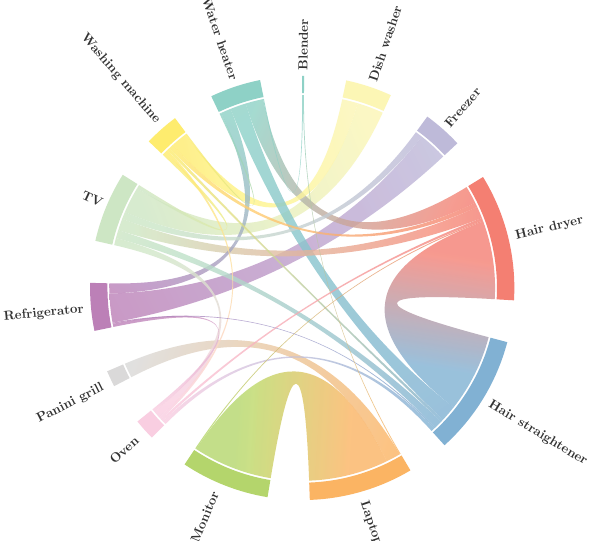
Figure 11. Concurrence plot using events identified from the IL ground-truth consumption data from six